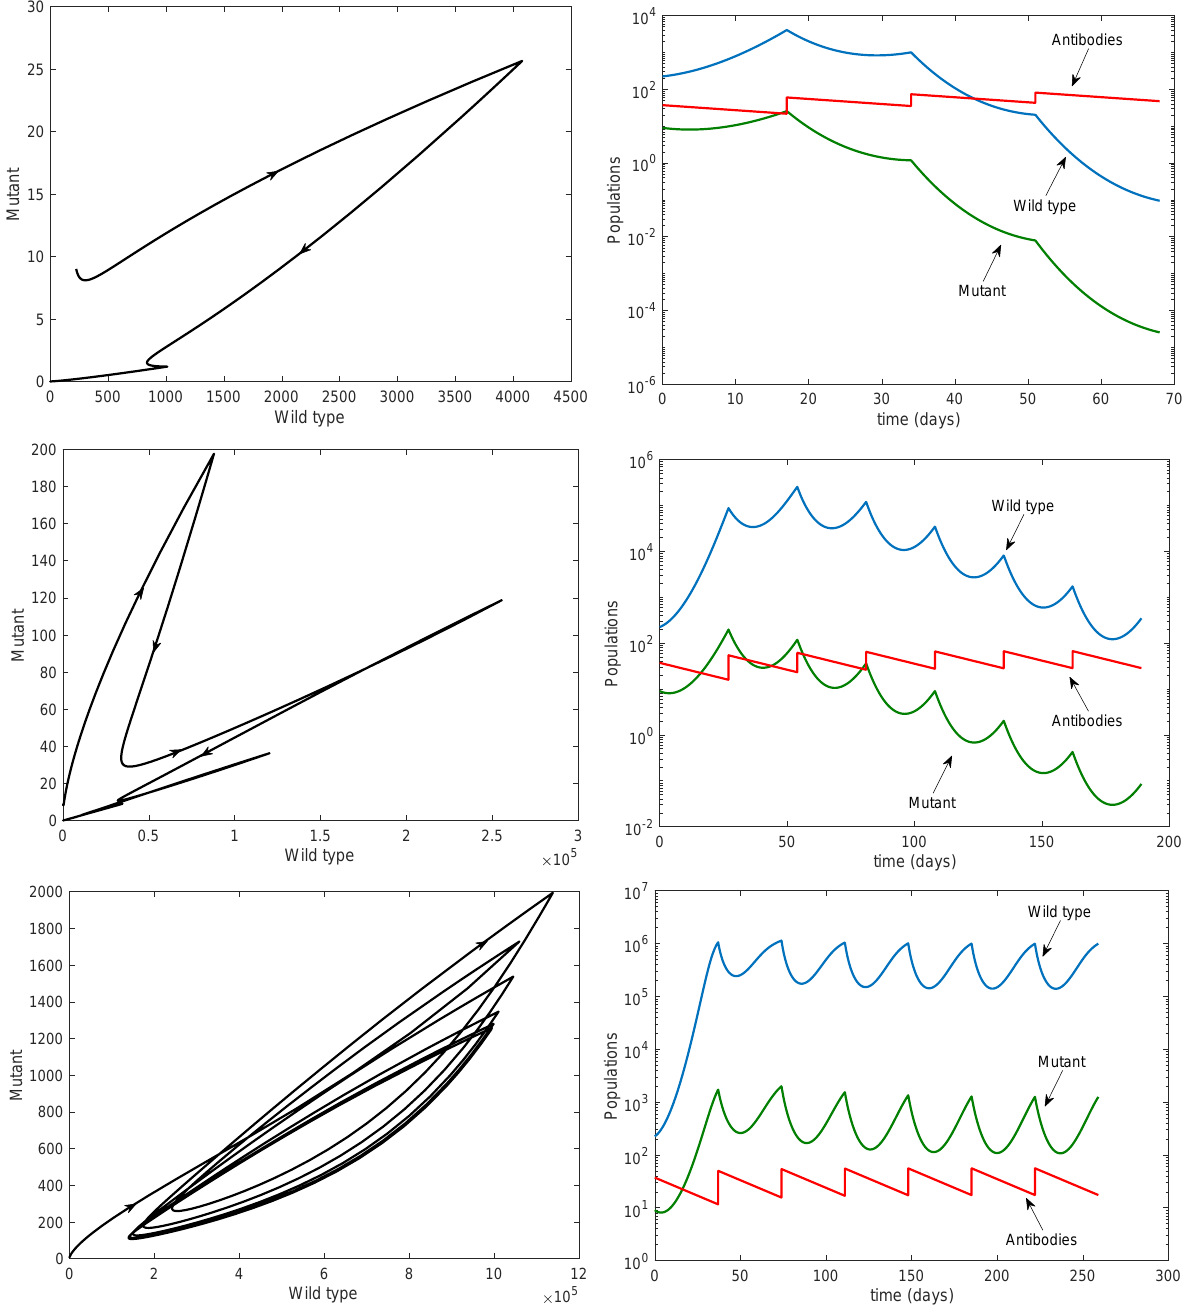
Figure 8. Effects of changing periods on the persistence of the wild type and mutant strains. All parameters are as in Table 1 except for the period. Left column: phase plane; right column: time series (note the log scale). Top row: τ = 17. Middle row: τ = 27. Bottom row: τ = 37. Note the different scales on the